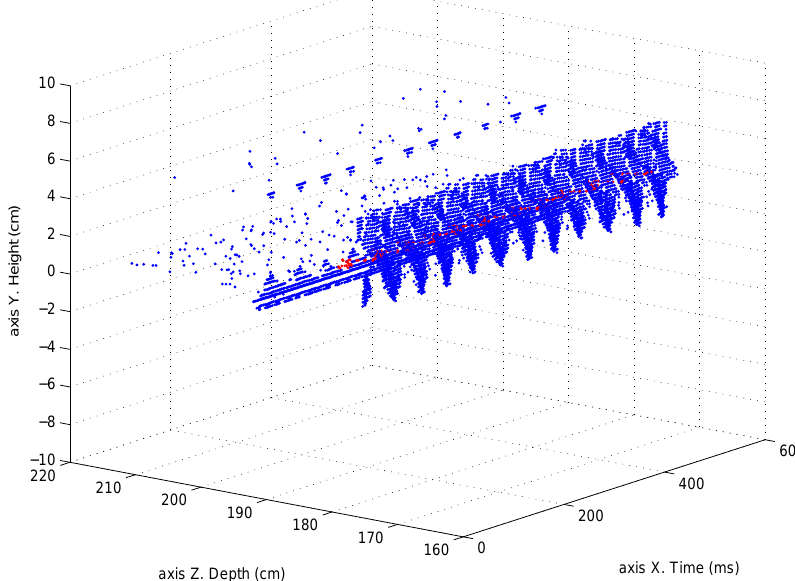
Figure 8. Helix depth and height as a function of time using classical processing with a 5 rps motor axis rotation